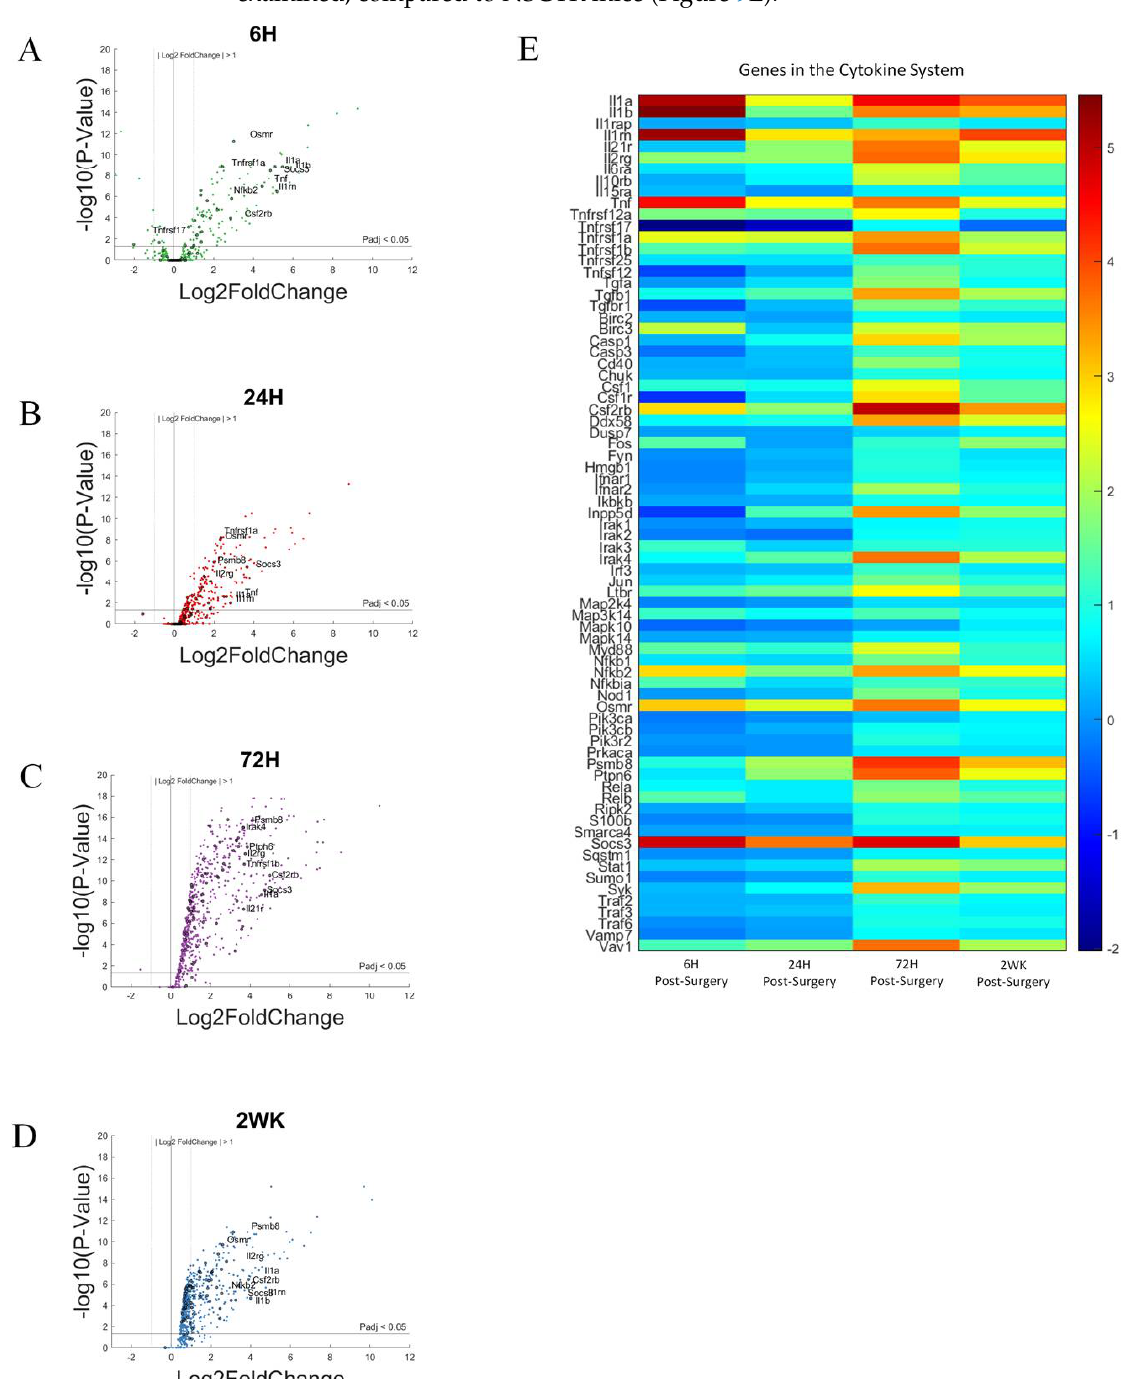
Figure 9. Differential expression of gene set involved in cytokine response compared to NSCTR mice: ( A – D ) volcano plot with genes in the cytokine system shown in black. Top 10 genes by differential expression level and P adj < 0.05 are labeled. Each time point post-surgery is on a separate volcano plot. ( A ) =6-h, ( B ) =24-h, ( C ) =72-h, and ( D ) =2-weeks. Color in ( A – D ) corresponds to time post-surgery color coding in other figures. ( E ) heatmap showing differential expressions of genes of the cytokine system at each time point post-surgery compared to